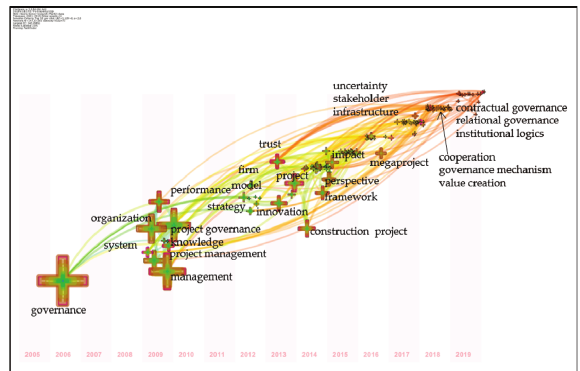
Figure 6: Time zone analysis of hot research topics according to the co-occurrence of keywords (modified from the original visuali- zation in CiteSpace).